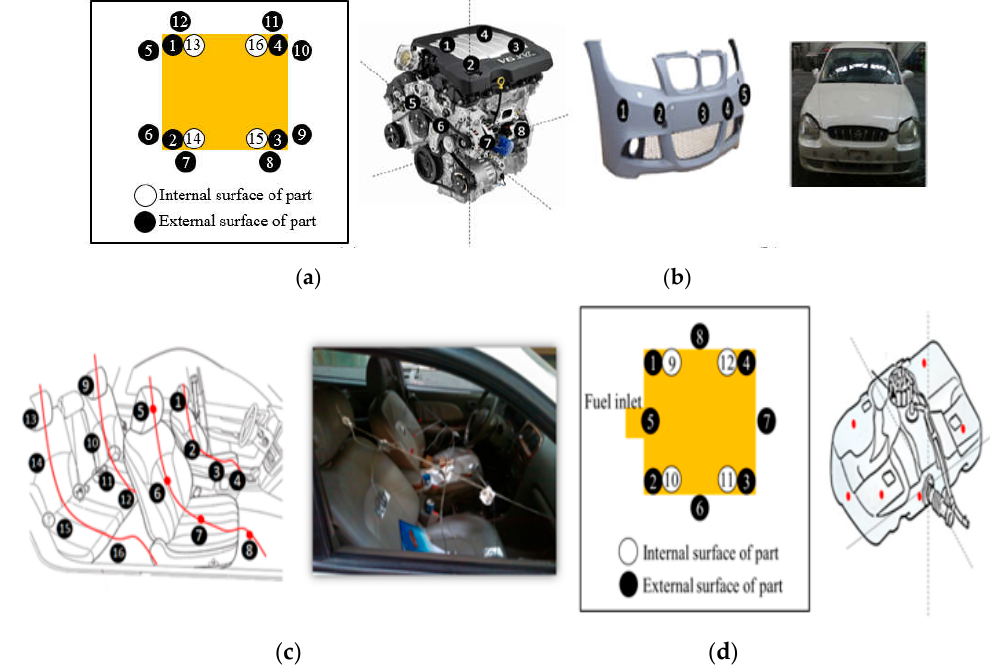
Figure 4. Location and number of thermocouples: ( a ) Engine room, ( b ) bumpers, ( c ) vehicle interior, and ( d ) fuel tank.